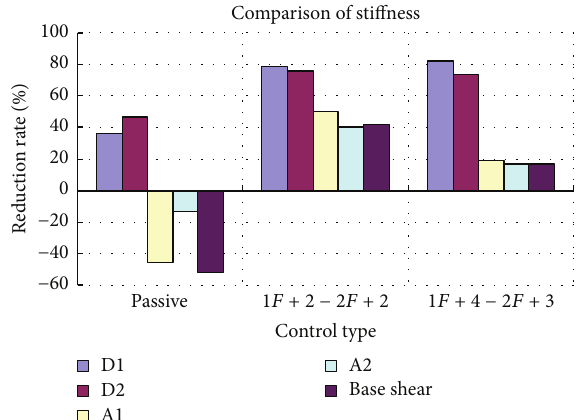
Figure 13: Comparison of the shock absorption ratios of the test structureunderexcitationoftheElCentroearthquakewithdifferent control types.